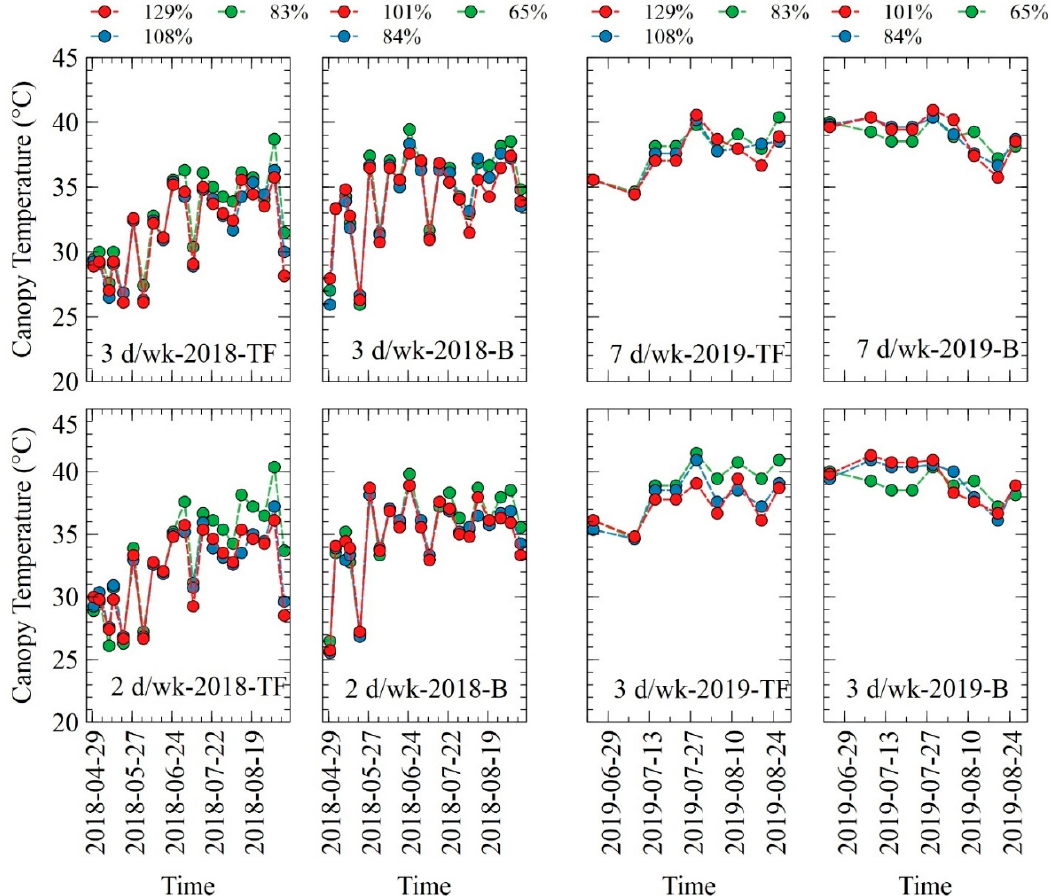
Figure 5. The canopy temperature dynamics of hybrid bermudagrass and tall fescue turfgrass plots under varying irrigation scenarios imposed in 2018 and 2019. d/wk: indicates irrigation frequency in days per week.